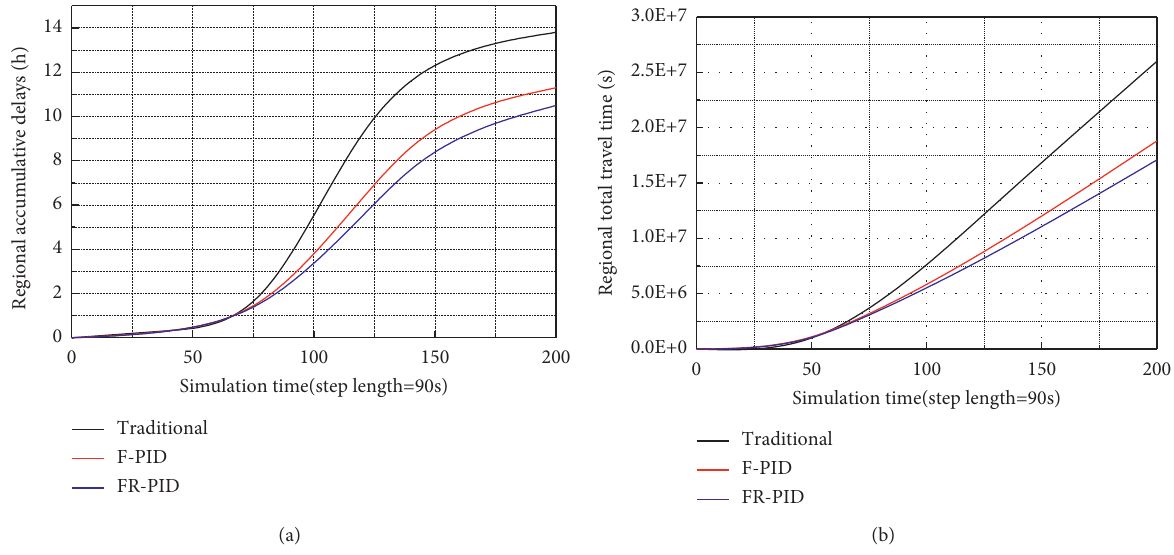
Figure 13: Accumulative delay and travel time of controlled area: (a) accumulative delay; (b) travel Table 2: Comparative analysis of regional accumulative delays and travel time.